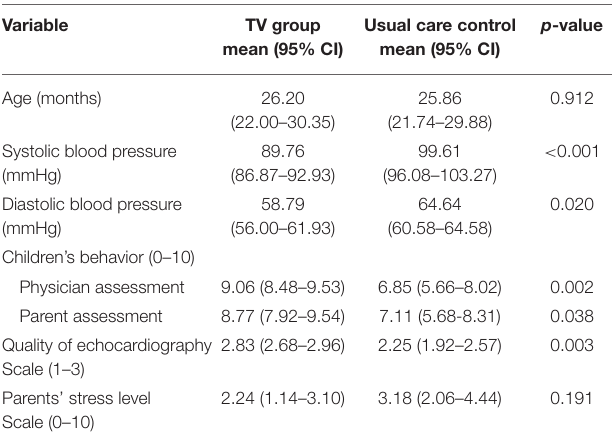
TABLE 2 | Bivariate